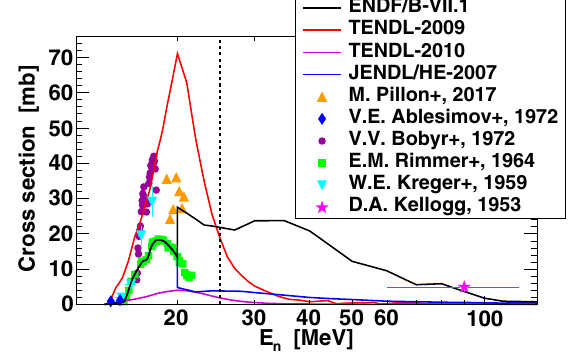
Figure 1. Compilation of the available experimental and eval- uated data on the 12 C(n,p) 12 B reaction cross-section. Huge dis- crepancies can be observed at the peak of the